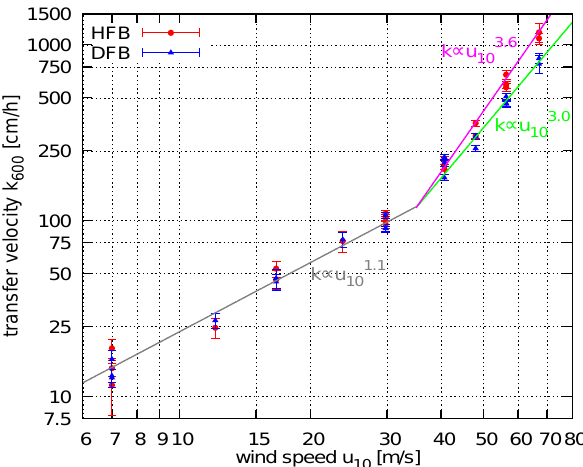
Fig. 6. Measured transfer velocities for HFB and DFB scaled to a Schmidt number of 600. Also shown are lines indicating propor- tionalities of the transfer velocities k 600 to u x the wind speed range and the